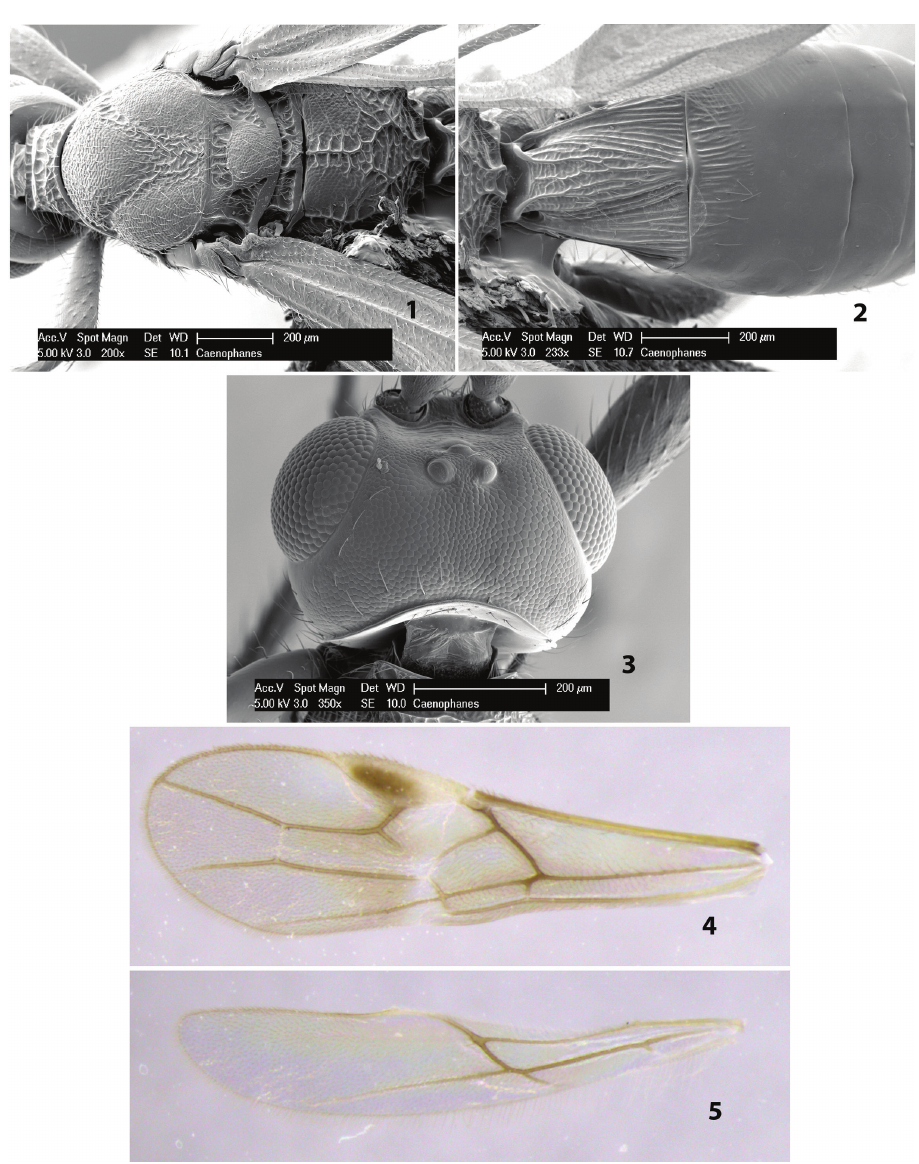
Figure 1–5. Caenophanes costaricaensis Marsh, n. sp.: 1 mesoscutum 2 metasomal terga 3 vertex, dorsal view 4 fore wing 5 hind